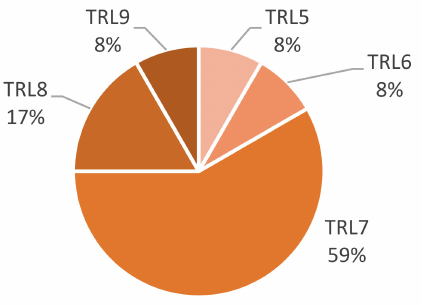
Figure 3. TRL of concept for technology developers.